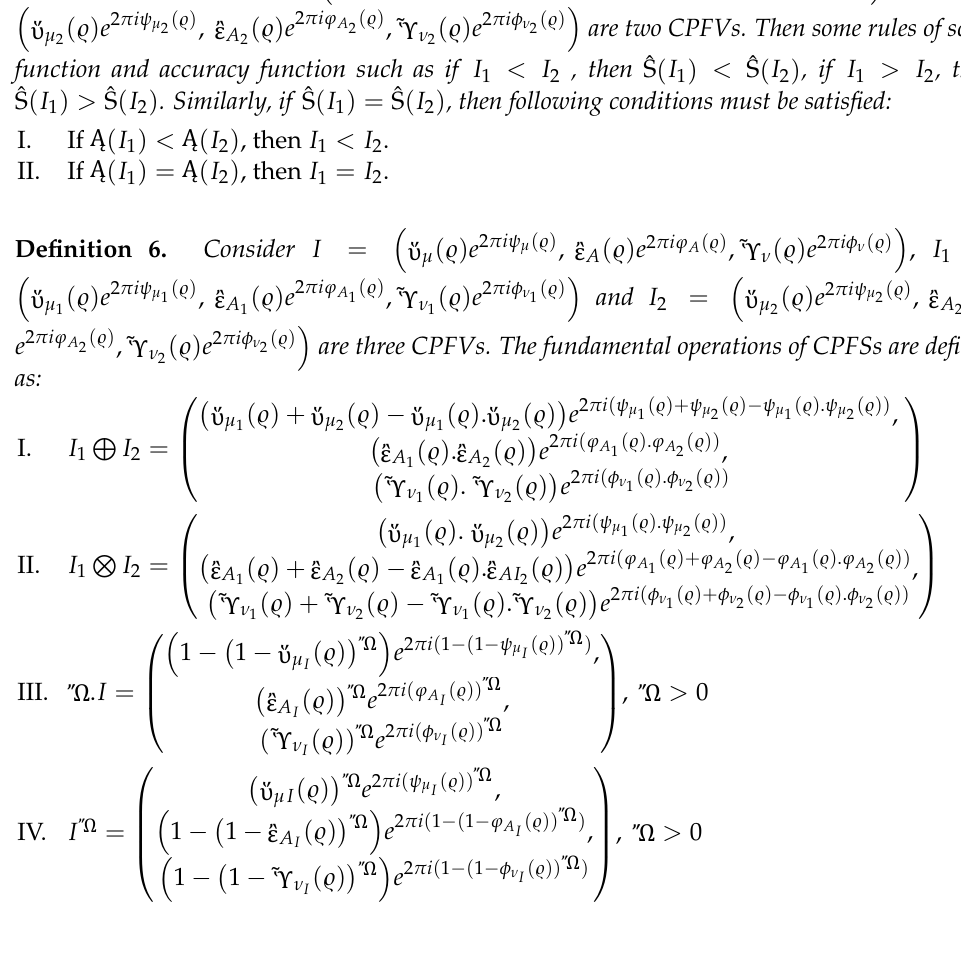
Table 1. Symbols and their meanings. Symbols Meanings Symbols Meanings